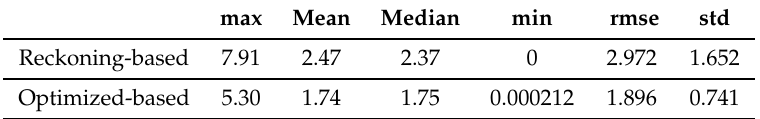
Figure 12. The evaluation of the resulting trajectories. ( a ) the data collection path, where the blue dot indicates the start and the red dot indicates the end. ( b ) comparison of the ground truth, the reckoning-based trajectory, and the optimized trajectory. ( c ) the absolute positioning error of the reckoning-based trajectory. ( d ) the absolute positioning error of the optimized trajectory. Table 3. The comparison of the absolute pose errors of trajectories in experiment II (in